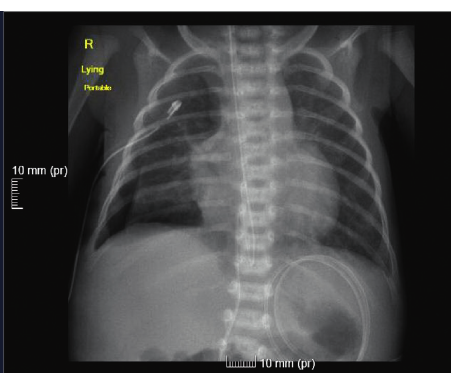
Figure 2: Chest X-ray after insertion of right-sided intercostal tube and octreotide